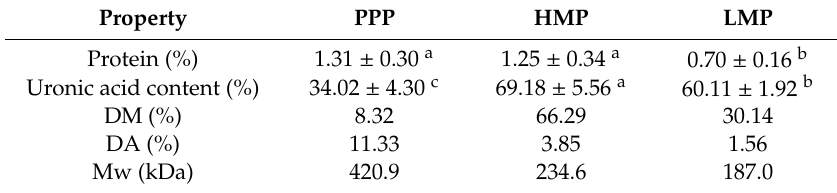
Table 1. Compositional properties of PPP, commercial HMP and LMP 1 .